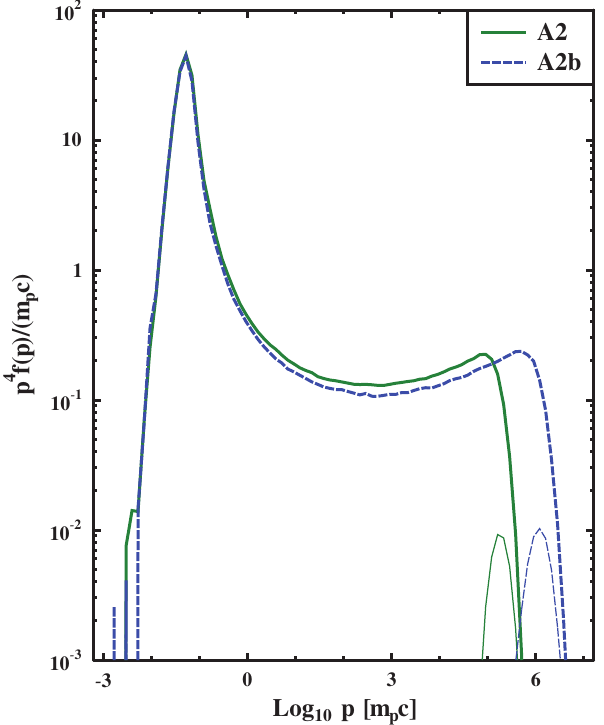
Figure 12. Particle distribution function in the shock rest frame, the thick curves correspond to the point x = 0 (the front shock), the thin curves correspond to the point x = x FEB . The correspondence to Table 1 is reflected in the